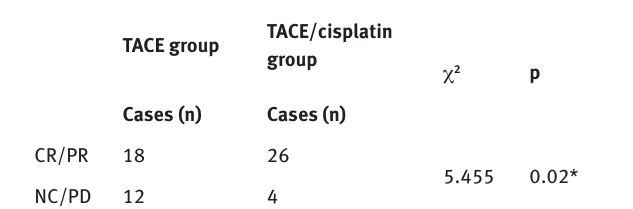
Table 2: The difference of effective outcome in two groups